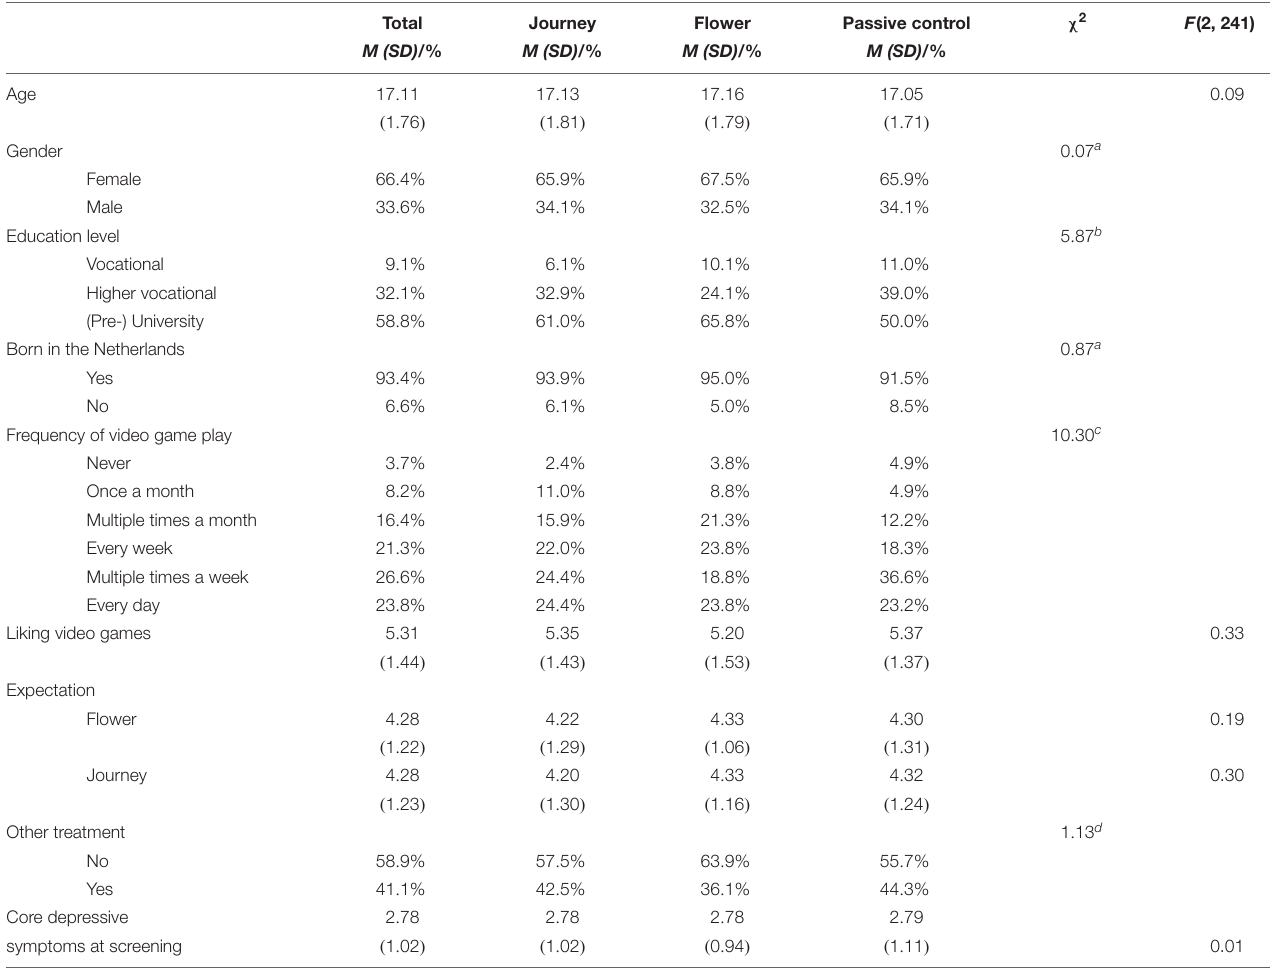
TABLE 2 | Descriptives (Means and Standard Deviations or Percentages) per condition and χ 2 or F -values for demographic variables at T0, intervention expectation at T1, and other treatment during the